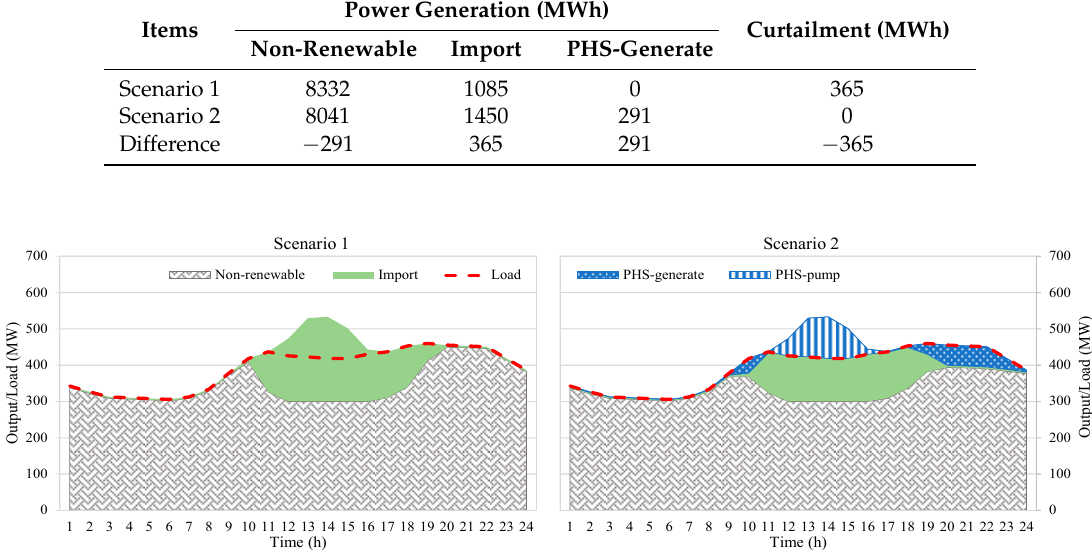
Table 3. Operation results of Scenario 1 and 2.